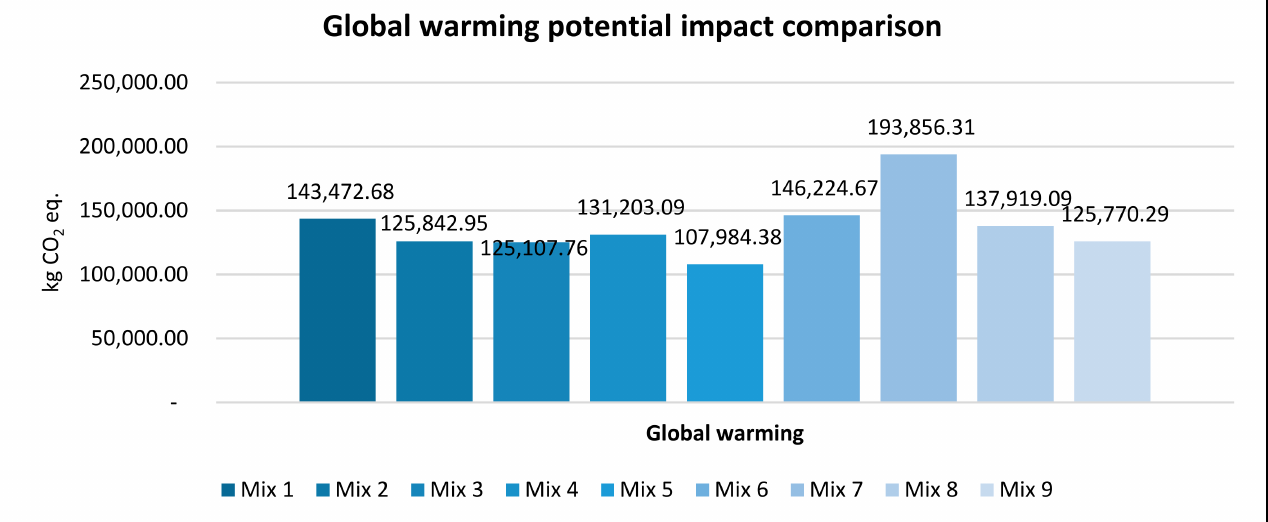
Figure 6. Global warming potential impact comparison between mineral sealing mix